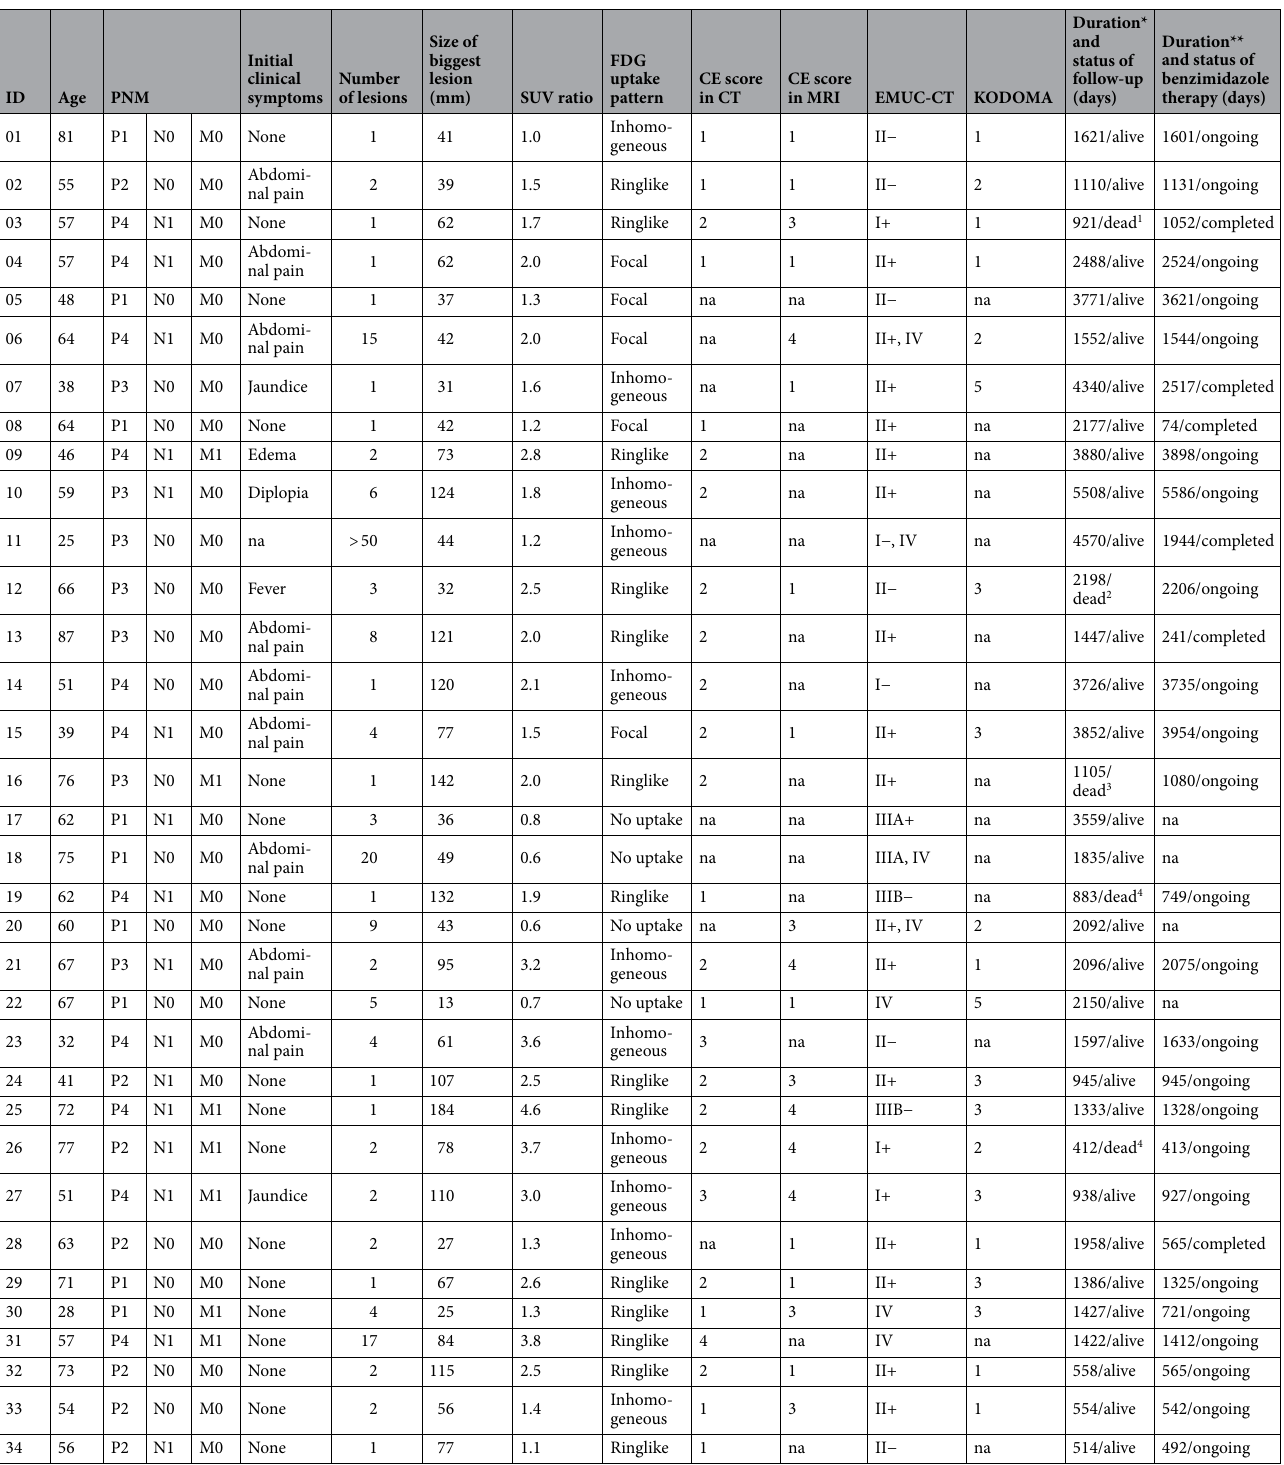
Table 3. Patient demographics of all inoperable patients with alveolar echinococcosis. ID patient identification, PNM (PNM stage: P = parasitic mass in the liver, N = involvement of neighboring